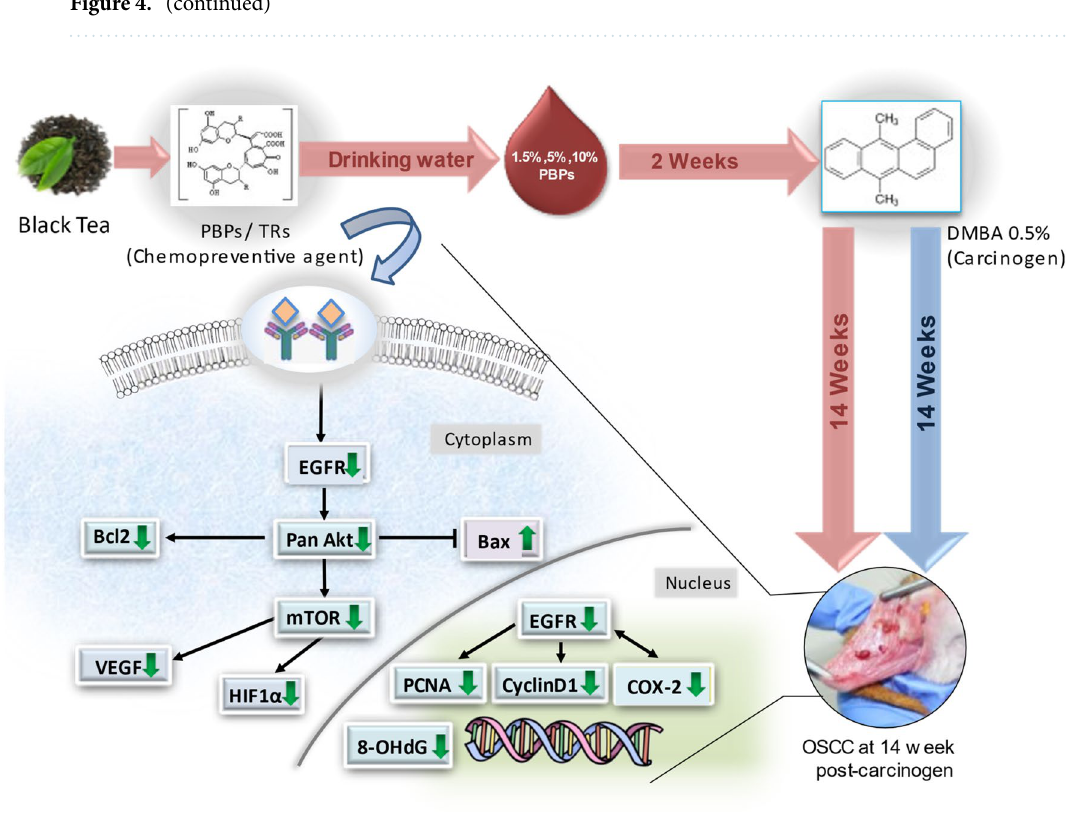
Figure 5. Schematic of the treatment plan and brief presentation of effect of PBPs on key biomarkers involved in process of oral